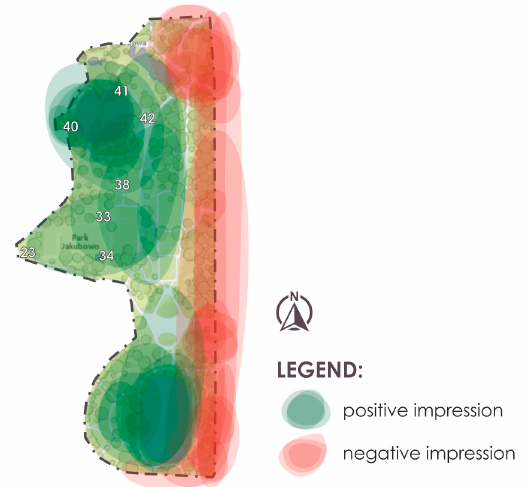
Figure 7. Mental map of the Jakubowo Park. Respondents identified noisy spaces (red) and noise-free and positive-sounding spaces (green).